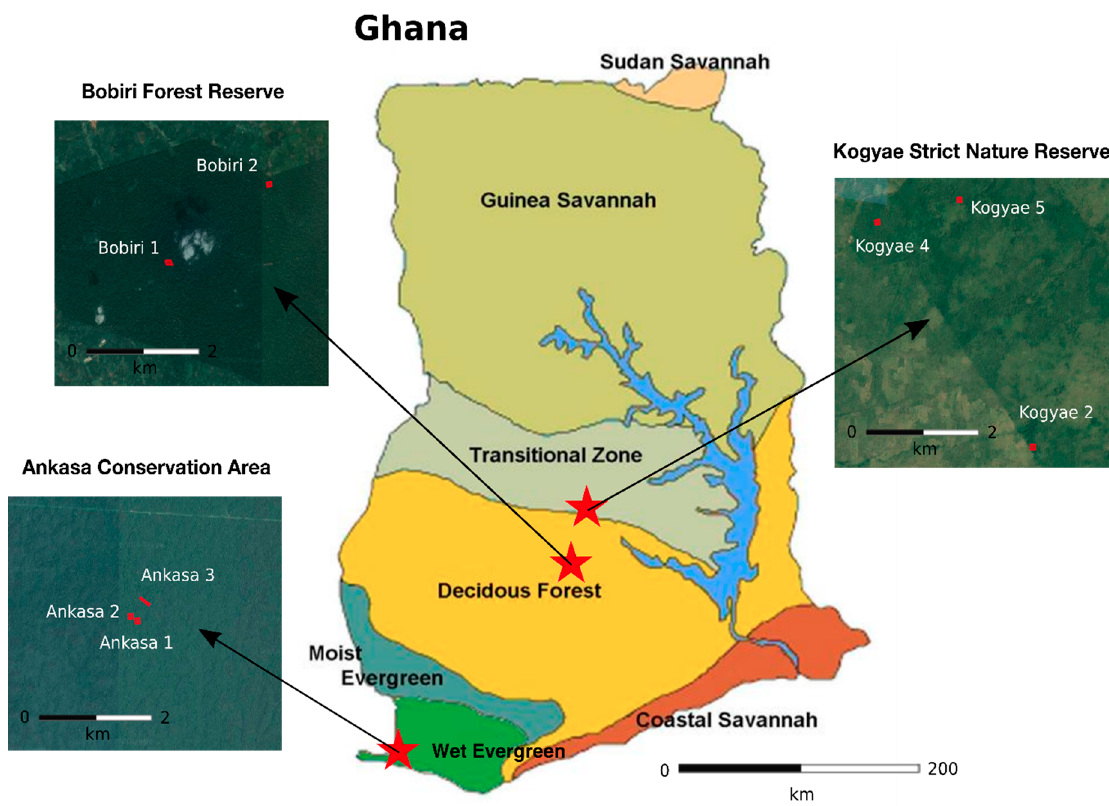
Figure 1. Map showing the major ecological zones of Ghana and location of research sites (Ankasa Conservation Area, Bobiri Forest Reserve and the Kogyae Strict Nature Reserve). Within each site, the one-ha study plots are outlined. Satellite photographs taken from Google Earth with permission.